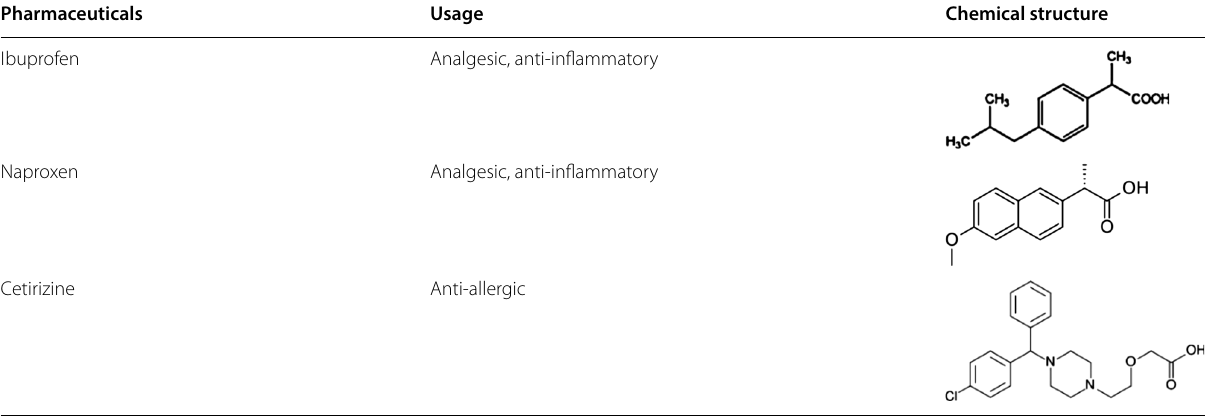
Table 1 Usage and chemical structure for Ibuprofen, Naproxen, and Cetirizine